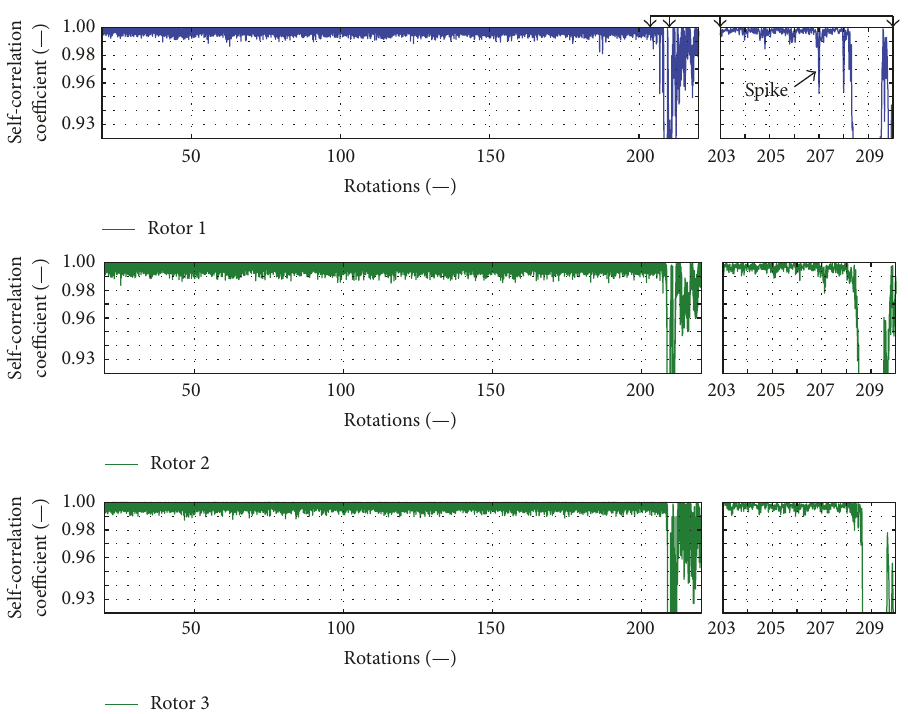
Figure 5: Disturbance detection by “self-correlation” of casing pressure signals at LE of rotors 1 to 3 at 100% Ω .